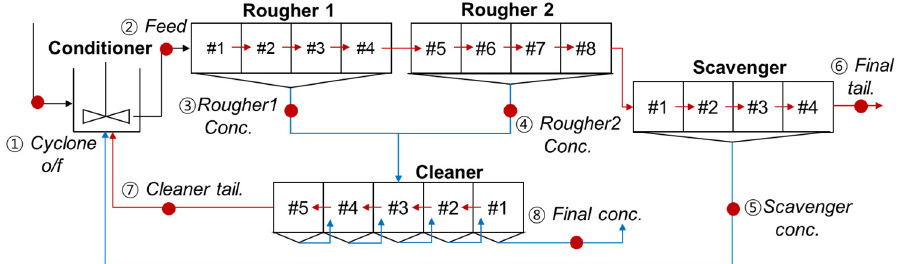
Figure 1. Flowsheet of gold ore flotation circuit. Blue line represents stream of floated products, and red line represents stream of sinked products after flotation. Red point represents sampling point: ① cyclone overflow (o/f); ② feed; ③ rougher 1 concentrate; ④ rougher 2 concentrate; ⑤ scavenger concentrate ⑥ final tailing; ⑦ cleaner tailing; ⑧ final concentrate. Table 1. Detailed information regarding flotation circuit in target beneficiation plant.